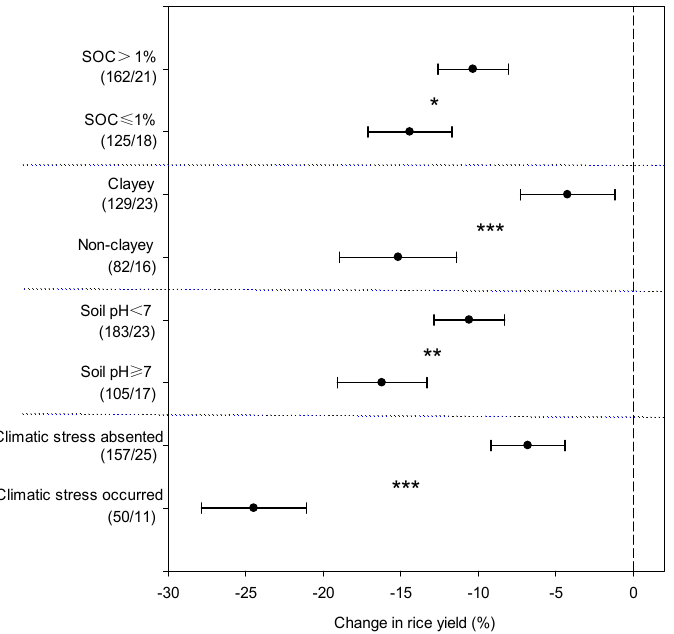
Figure 4. Influence of different soil organic carbon content (SOC), soil texture, soil pH, and climatic stress occurrence on the yield change of direct-seeded rice relative to transplanted rice. The number of paired observations/number of studies included in each dataset is presented in parenthesis. Significant differences by categories are based on randomization tests. ns denotes non-significance at 0.05, * denotes significant at p ≤ 0.05, ** denotes significant at p ≤ 0.01, and *** denotes significant at p ≤ 0.001.